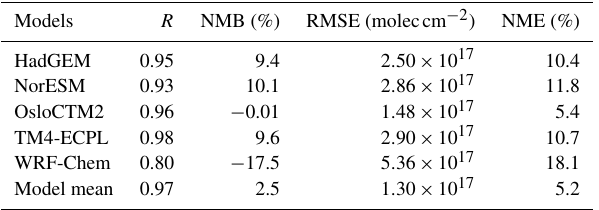
Table 4. Statistical parameters (correlation coefficient R , normal- ized mean bias NMB, root mean square error RMSE and normalized mean error NME) based on spatial variations for model simulations of 0–20km ozone column over Asia in August 2008 compared to the IASI ozone FORLI